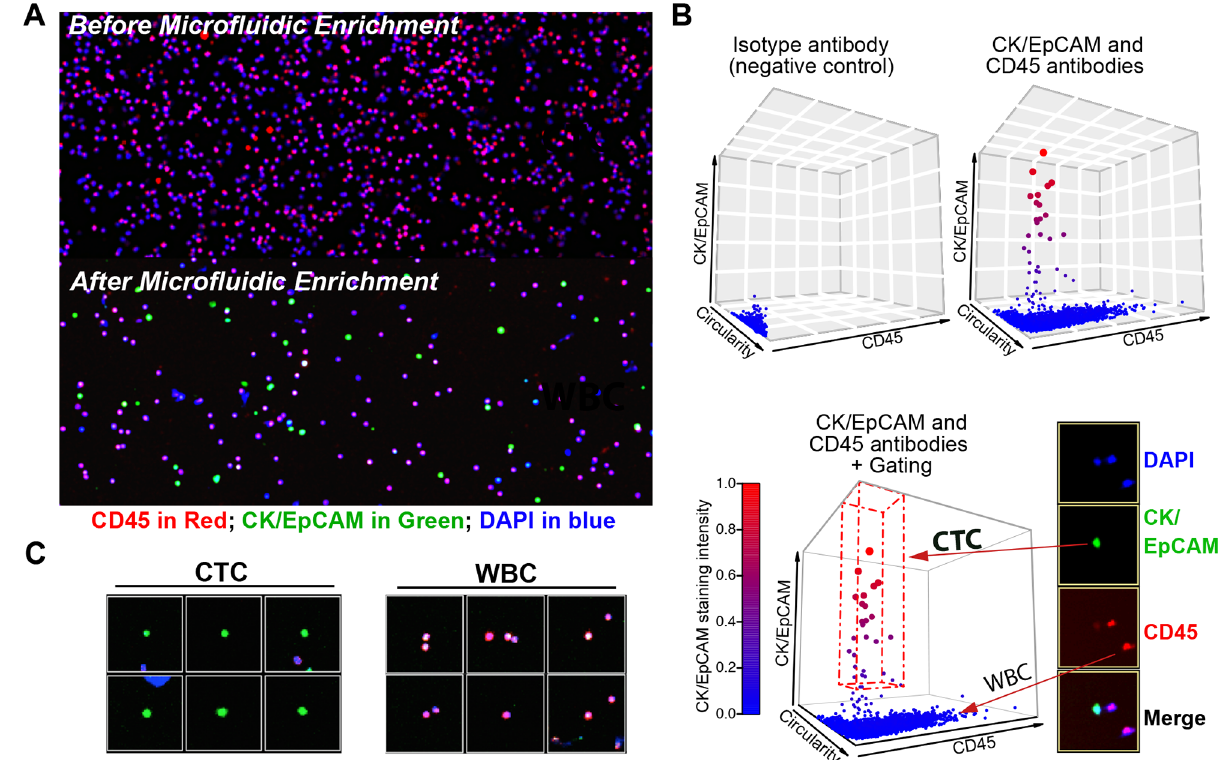
Fig 2. CTC staining, gating, and visualization. (A) Immunofluorescence stainingof blood samples before and after microfluidic enrichment. The samples were stained with DAPI (blue), CK/EpCAM (green), and CD45 (red) antibodies.(B) 3D plots showingdata extracted from CellProfiler. Cells from buffy coats were stained with isotype control antibodies and served as negativecontrols. The box with red dashed line indicatesgating of CTCs. (C) Individual cell image gallery generatedfrom the enumerationpipeline.CTCs (DAPI + CK/ EpCAM + CD45 − ) and WBCs (DAPI + CK/EpCAM − CD45 + ) are shown.